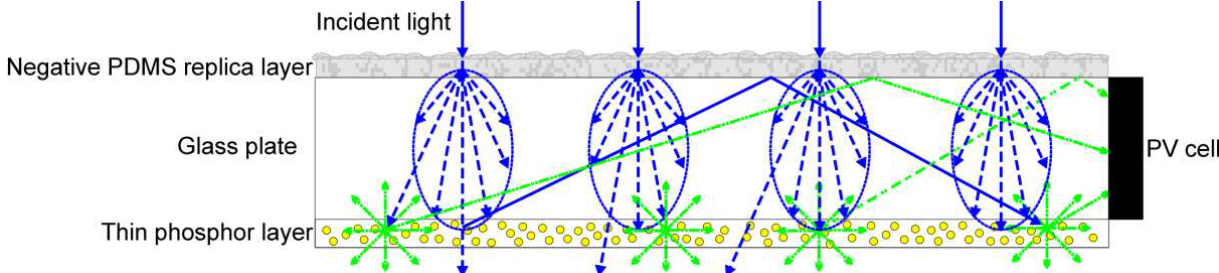
Figure 9. Schematic representation of the semi-transparent thin-film LSC implementing the negative PDMS replica layer of leaves’ microstructures. Reprinted with permission from Ref. [69]. 2022, license CC BY 4.0 (https://creativecommons.org/licenses/by/4.0/ (accessed on 20 October 2022)).